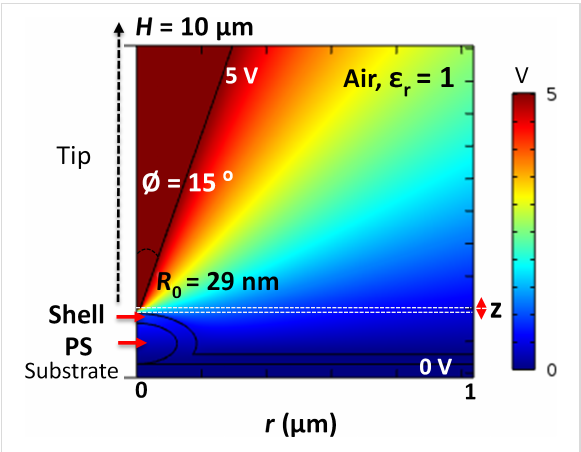
Figure 11: Typical simulation of the electric field map obtained with a 2D axisymmetric model of the EFM tip and the PS + Al 2 O 3 sample as a